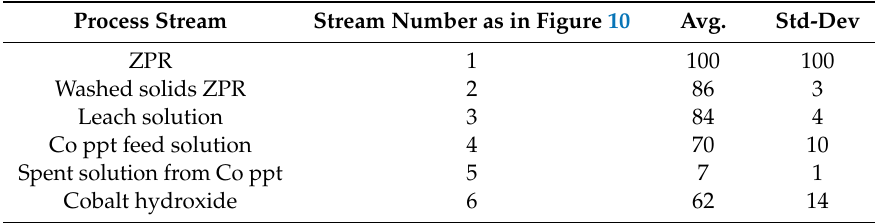
Table 10. Distribution (%) of the cobalt in the process streams of the circuit of Figure 9. Process Stream Stream Number as in Figure 10